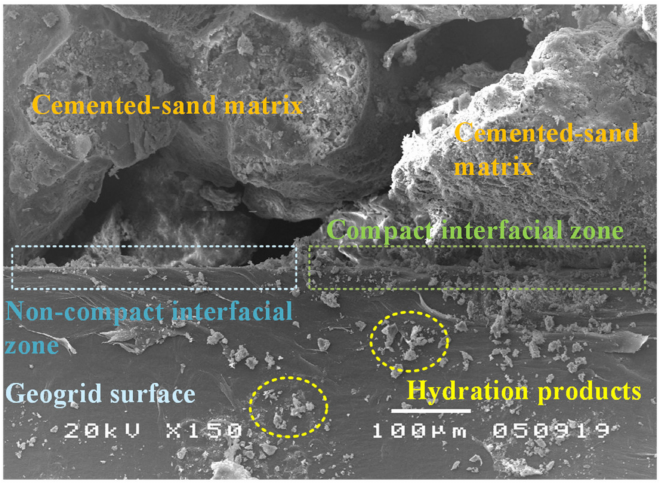
Figure 13. SEM image of the uniaxial geogrid surface in the cement-treated sand. Two main interface characteristics of the cement-sand matrix and geogrid were ob- served, including compact and non-compact interfacial zones. In the compact interfacial zone, the cement-sand matrix around the geogrid surface fully hydrates and fill the space between the geogrid and the matrix, resulting in no observed interface separation